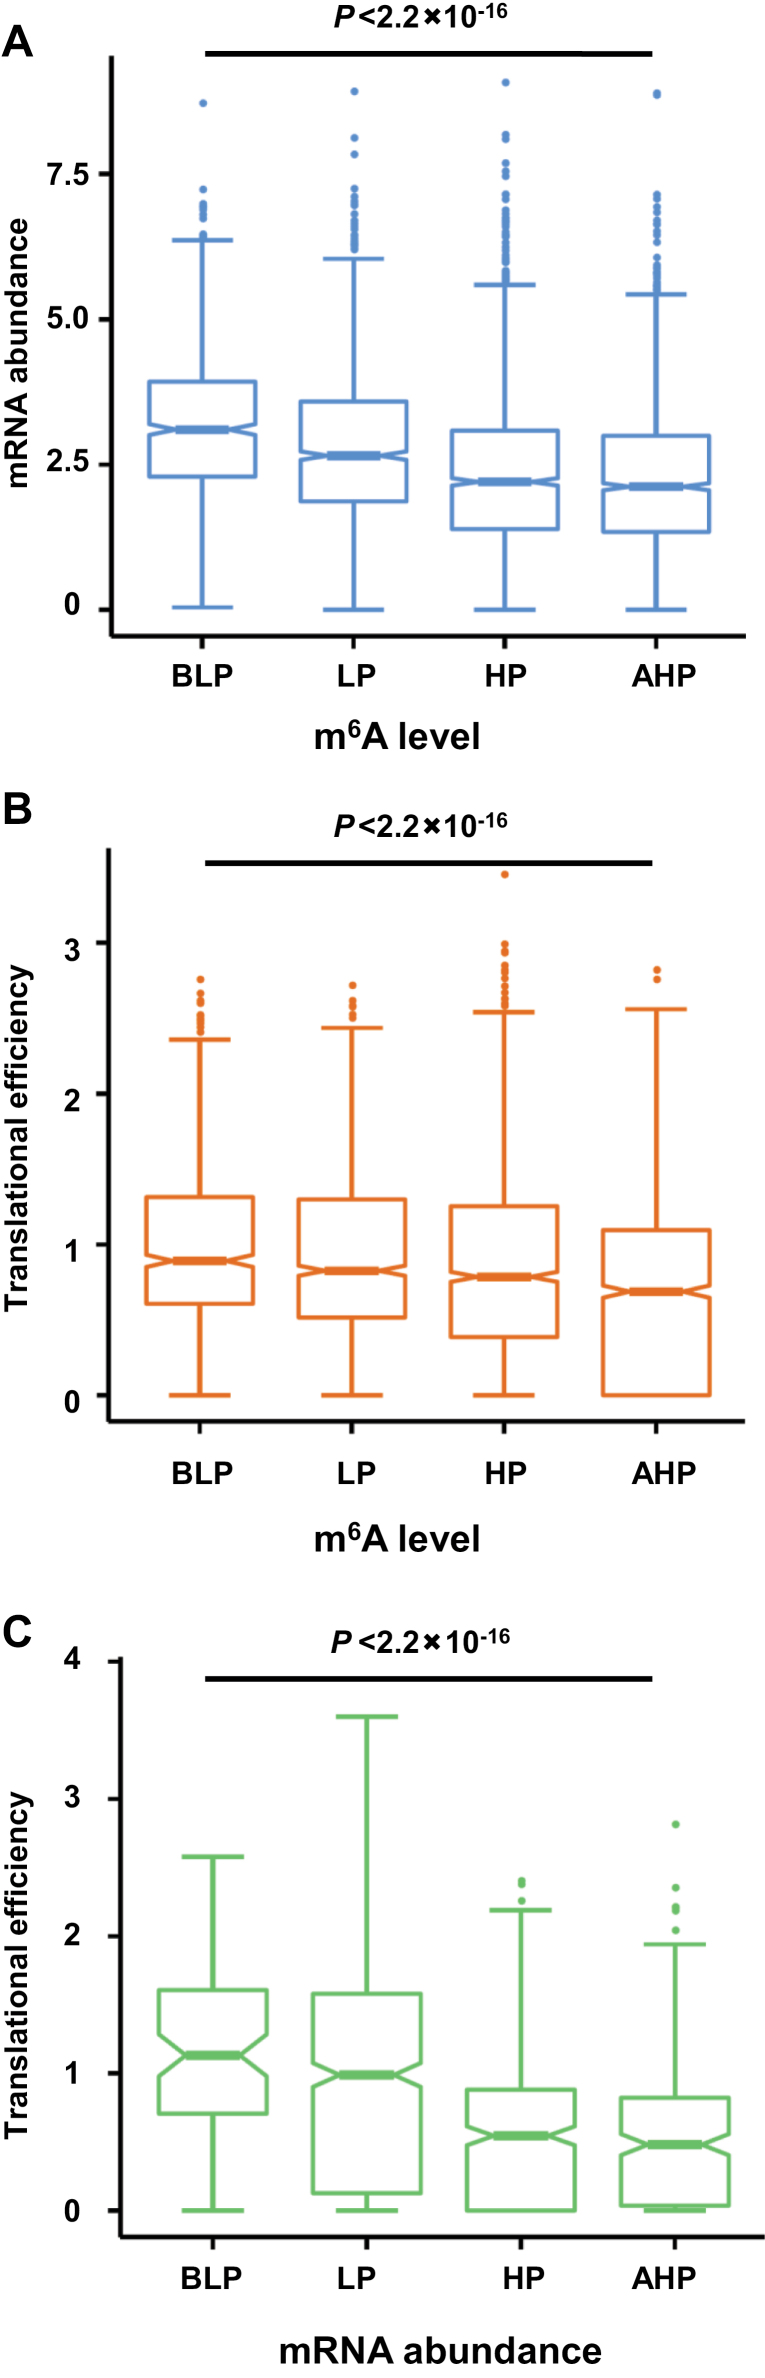
Relationship of gene expression at the levels of mRNA abundance, m6A modification, and translational efficiency in the hybrid. (A) Correlation between mRNA abundance and different patterns of non-additively m6A-modified genes. (B) Correlation between translational efficiency and different patterns of non-additively m6A-modified genes. (C) Correlation between translational efficiency and different patterns of non-additively transcribed genes. The P-value was calculated using the Kruskal–Wallis test.